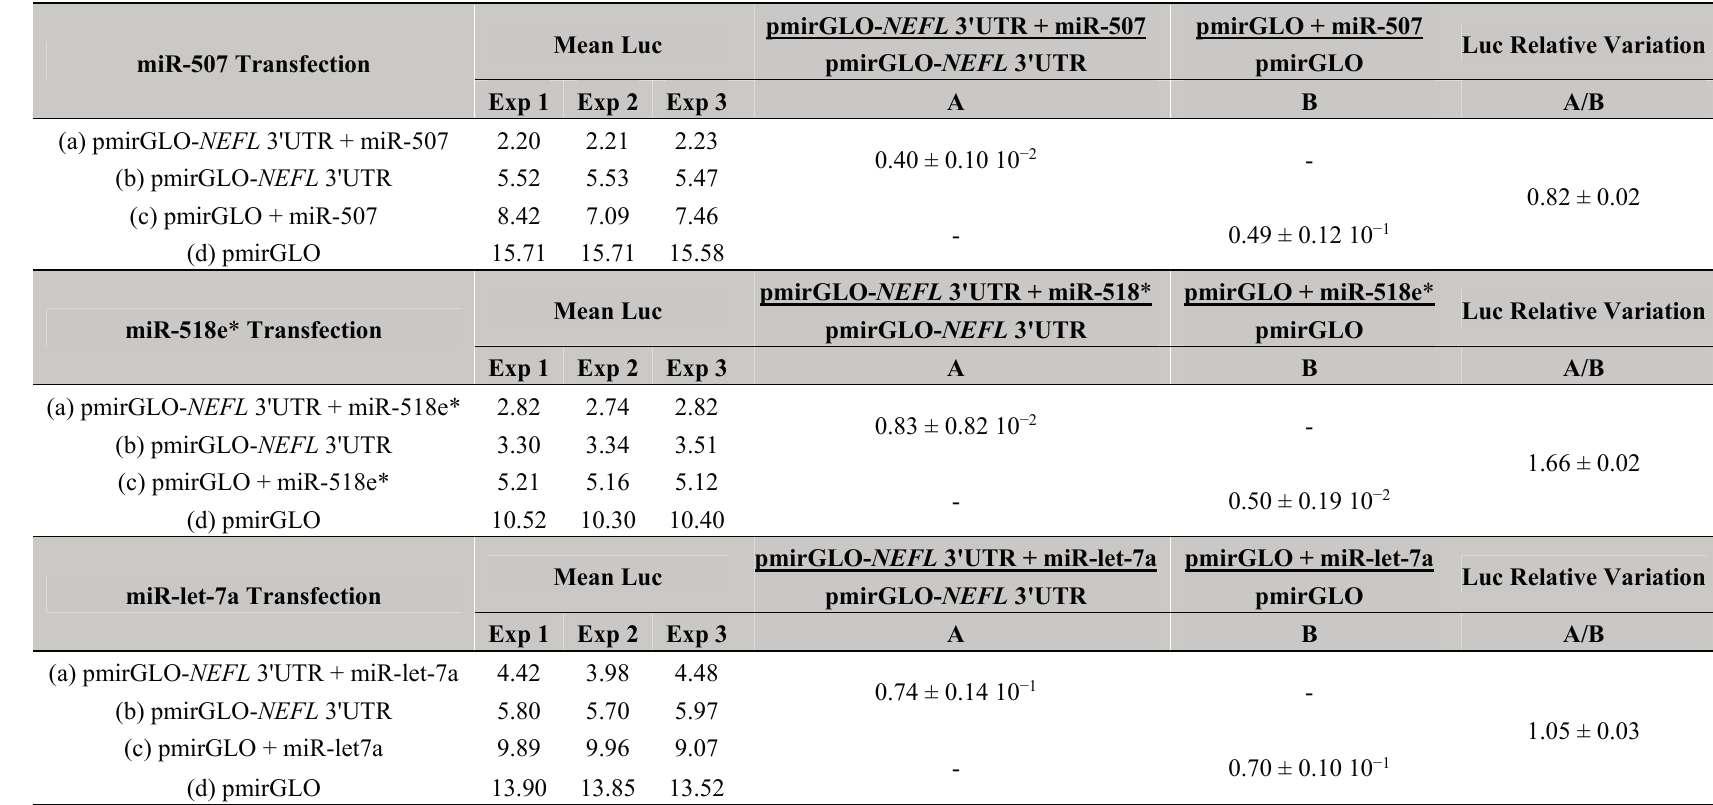
Table 1. Luciferase reporter assay data for miR-507, miR-518e* and miR-let-7a effects on NEFL 3'UTR. Mean miR-507 Transfection